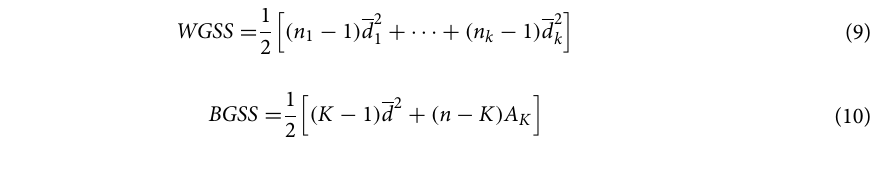
n represents the number of samples in dataset, K represents the number of categories. The values of WGSS and BGSS are obtained by formula 9 and 10: